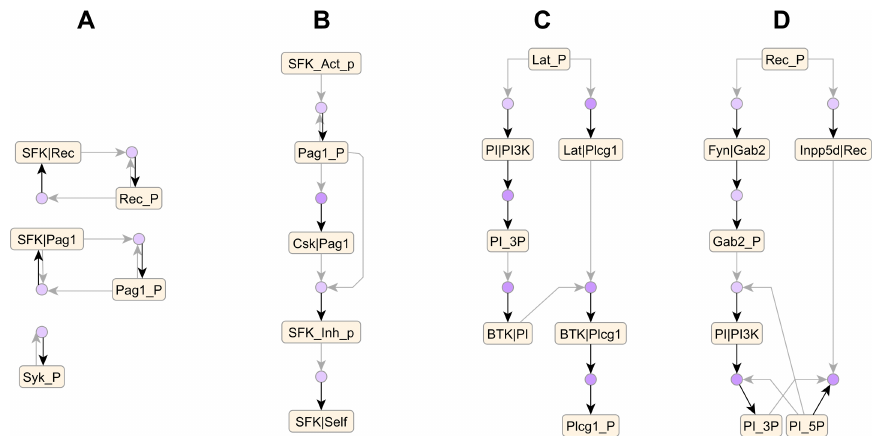
Fig 9. Signaling motifs in the Fc ε RI library recoveredfrom the compressedAR graph. (A) Positive feedbackloops enhancebindingof Src family kinasesLyn and Fyn (denotedSFK) to receptor and Pag1 scaffold as well as Syk auto-phosphorylation.(B) Pag1 phosphorylated by SFKs recruits Csk, which negatively regulatesSFKs by phosphorylation. (C) A coherent feed-forward loop activates Plcg1 from phosphorylated Lat. (D) An incoherentfeed-forward loop involvingenzymes PI3K and Inpp5d(a.k.a. SHP2) regulateslevels of phosphoinositidePIP3, which is phosphorylated at both 3’ and 5’ hydroxyl positions (denotedPI_3P and PI_5P respectively).